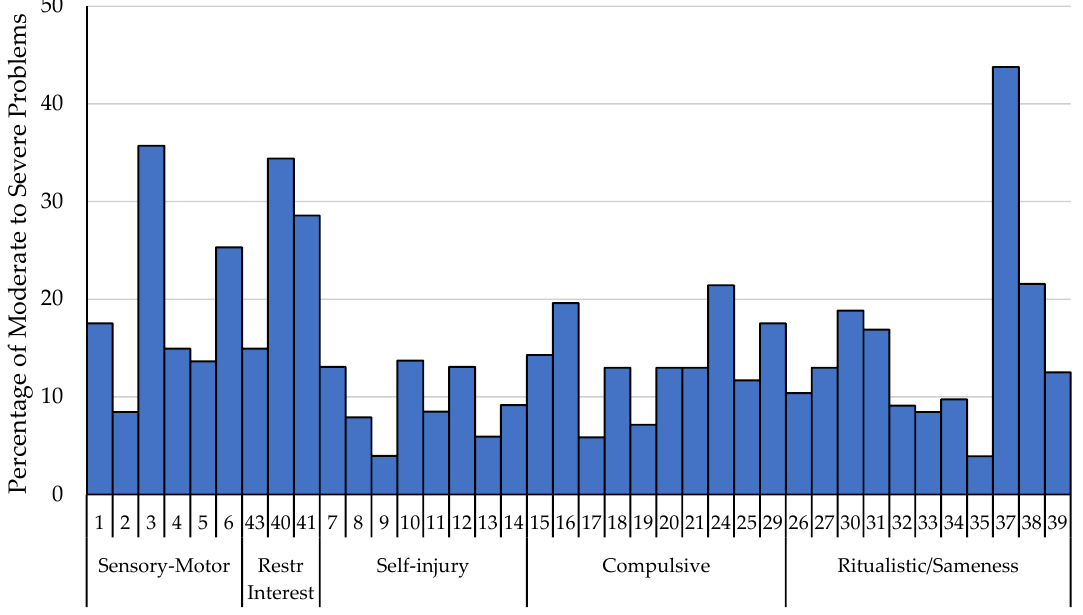
Figure 1. Average percentage of caregivers reporting behaviors to be a moderate to severe problem (a score of 2 or 3) for the total sample across the RBS-R items.